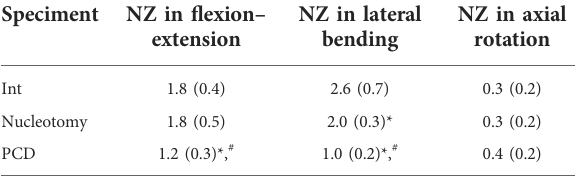
TABLE 2 Neutral zones in different conditions ( n =8, ±SD, degree,